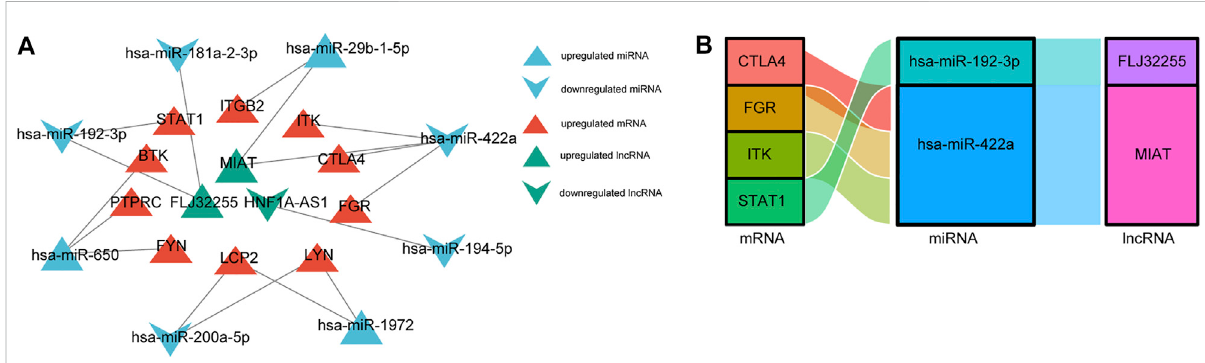
FIGURE 7 The construction of (A) ceRNA network. The triangle represents up-regulate, and v represents down-regulate. Red color represents mRNAs, bluecolorrepresentsmiRNAs,andgreencolorrepresentslncRNAs. (B) Sankeydiagramof fi nalceRNAnetwork.ThesquarenessrepresentslncRNAs, miRNAs, and mRNAs, and the size indicates their degree of